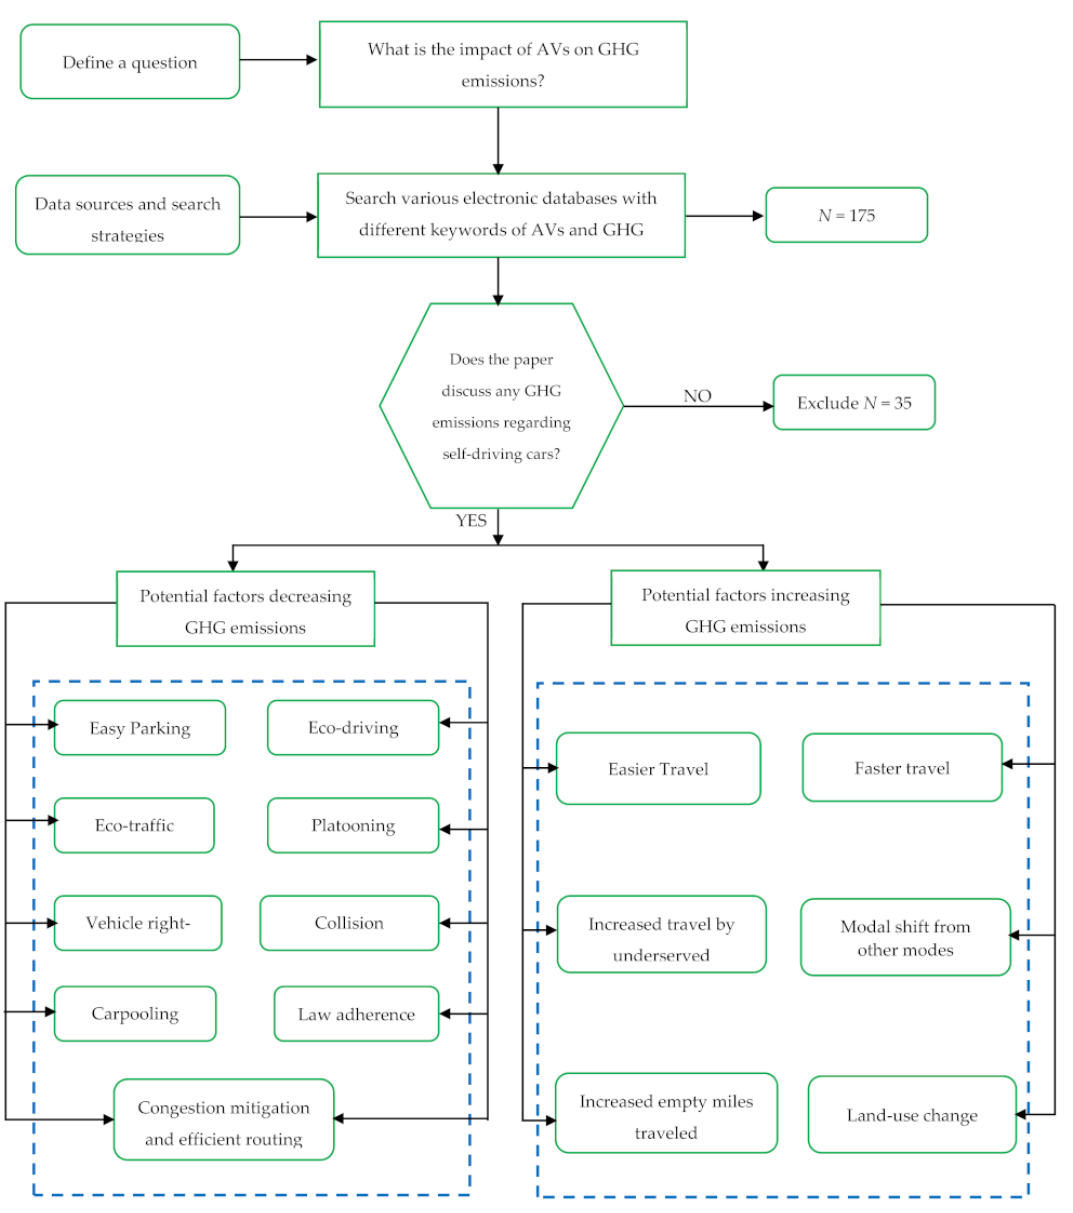
Figure 1. Methodology